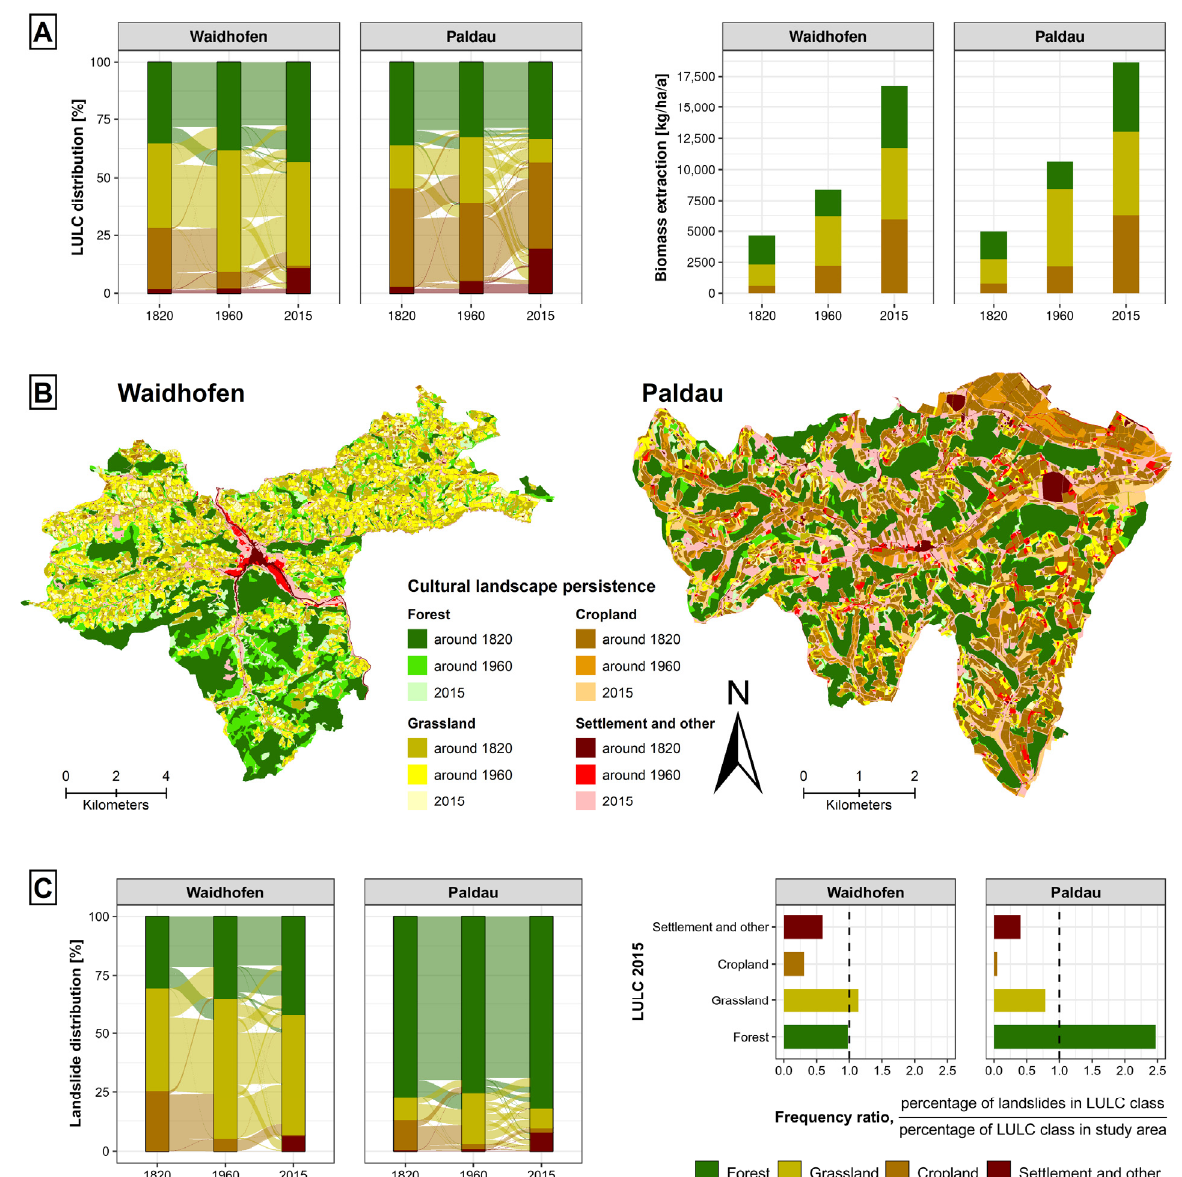
Figure 2. LULC change in the study areas for different time cuts. ( A ): Changes of LULC patterns (in %, left) and changes of biomass extraction (in kg/ha/a, right). ( B ): Cultural landscape persistence maps showing persistent historical structures in present-day LULC. ( C ): Landslide distribution for different LULC patterns (in %) and their changes (left), and landslide frequency ratios for the LULC pattern in 2015 (right).